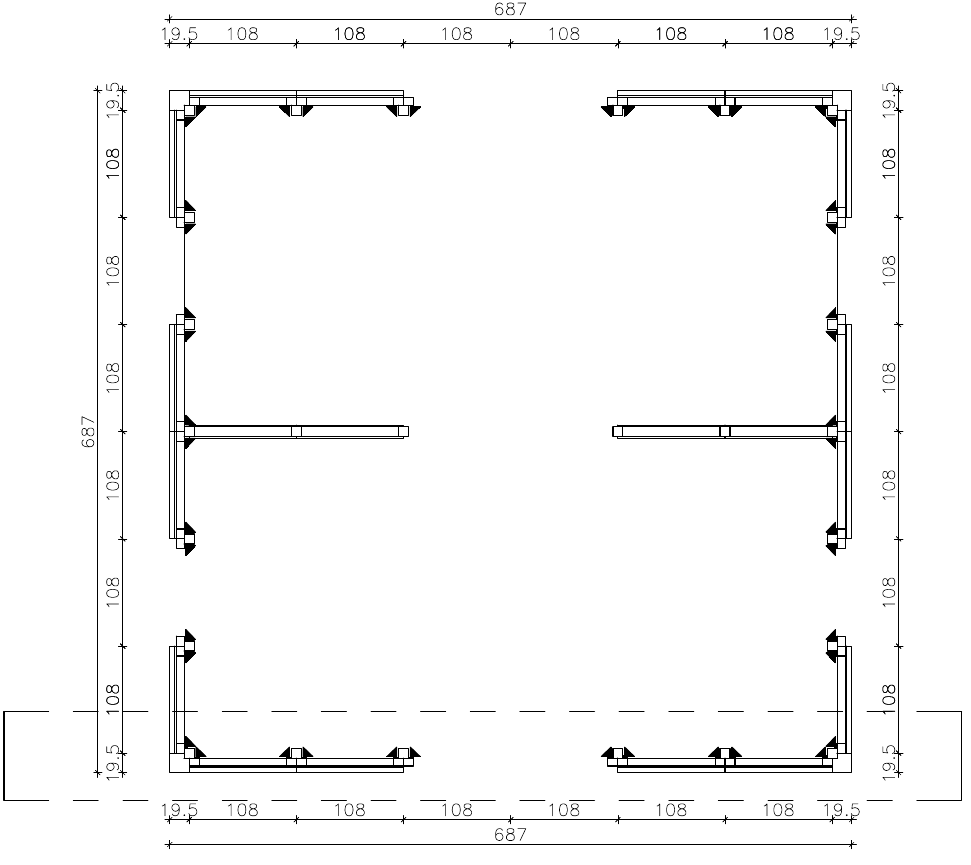
Figure 14. Case-study building: First-storey plan (dimensions in